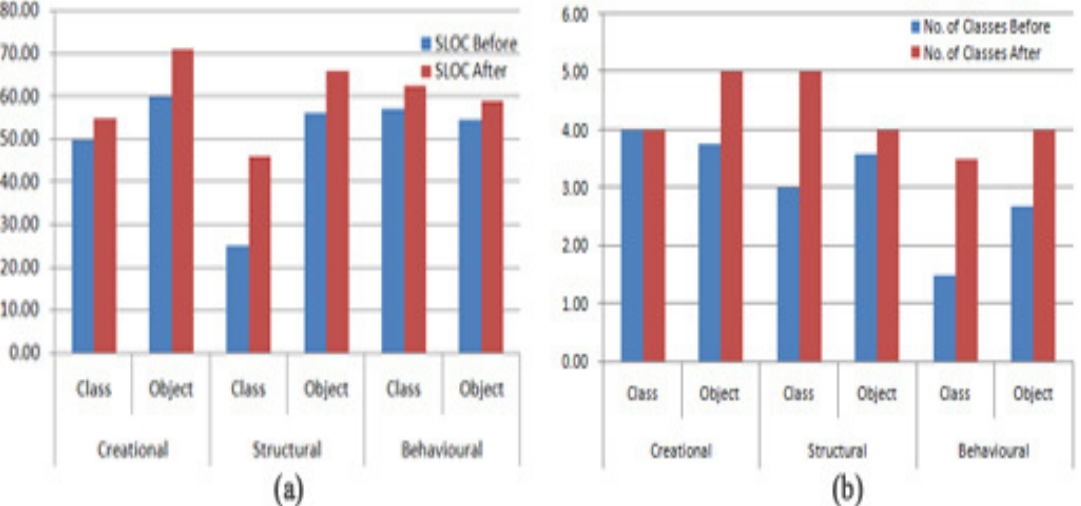
FIG.7. IMPACT ON SIZE AND NUMBER OF CLASSES FOR DIFFERENT CATEGORIES OF DESIGN PATTERNS (A) SIZE (SLOC) (B) NUMBER OF